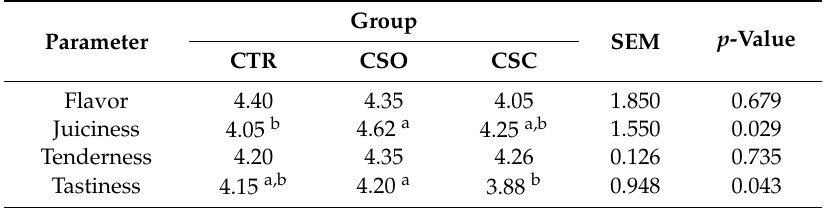
Table 8. Results of the sensory analysis of the breast muscles ( Pectoralis major ) of broiler chickens (according to a 5-point scale: 5—the highest score; 1—the lowest score). Group Parameter SEM p -Value